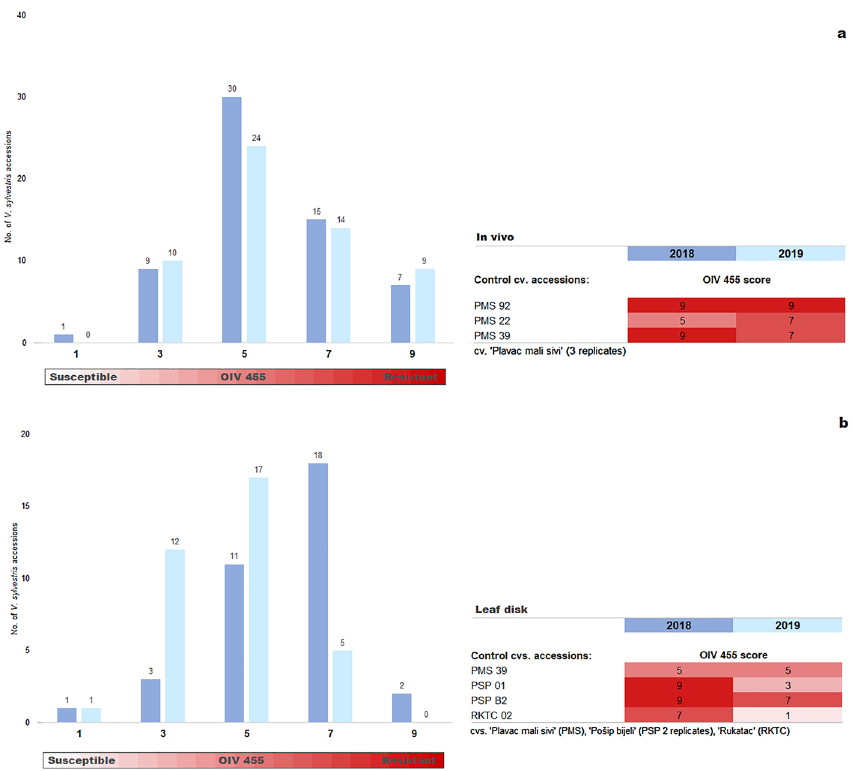
Figure 2. Resistance of V. sylvestris seedlings to grapevine powdery mildew ( E. necator ) based on OIV 455 descriptor five-class scale (1–9) and two phenotypic approaches: ( a) In vivo evaluation in 2018 encompassed 62 accessions and 57 accessions in 2019. V. vinifera cv. ‘Plavac mali sivi’ (PMS) was used as control. ( b) Leaf disk assay on a subset of 35 V. sylvestris accessions in 2018 and 2019. Three V. vinifera cvs. were used as controls. Each chart column in (a,b) shows the number of different accessions sharing the same OIV score (level of resistance) in the year of evaluation. Unless otherwise indicated, all accessions were represented by a single biological